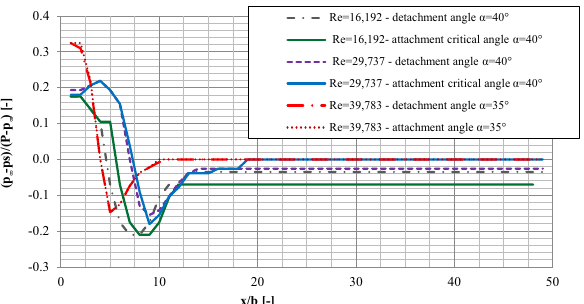
Figure 10. The comparison of pressure distributions on the plate at the same value of the plate inclination for the examinations in the direction of detachment and